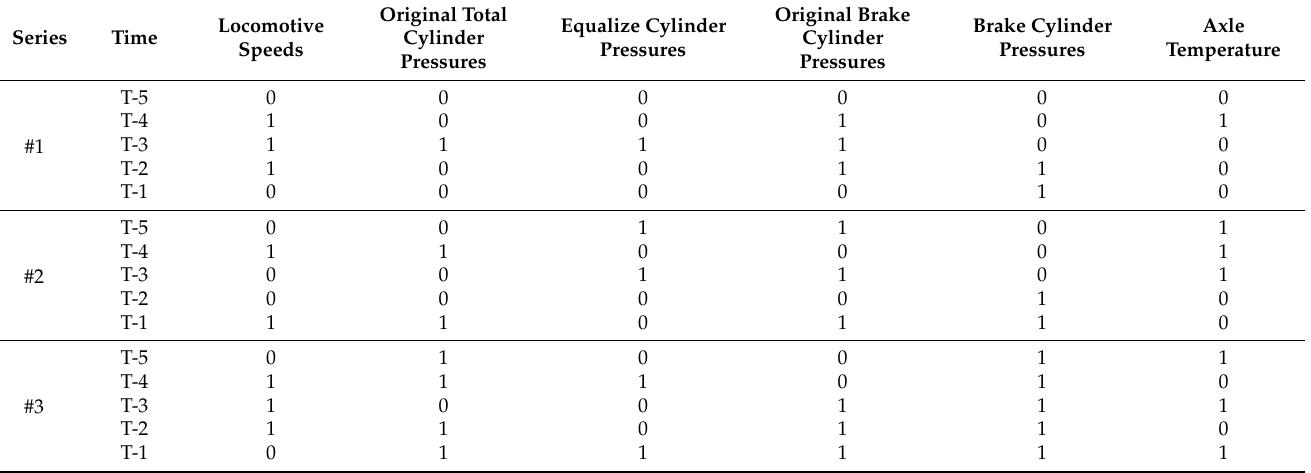
Table 3. Feature selection results of reinforcement learning method for the axle temperatures